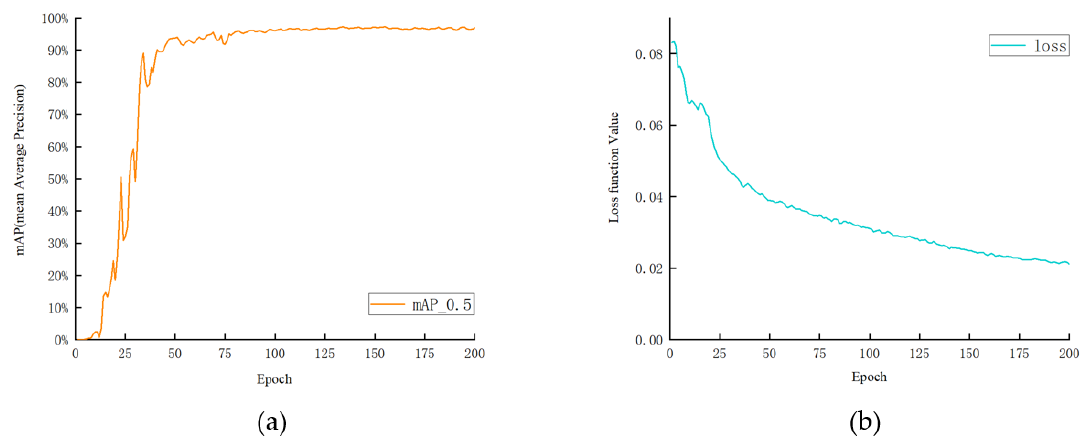
Figure 10. The training result: ( a ) mAP ; ( b ) loss.